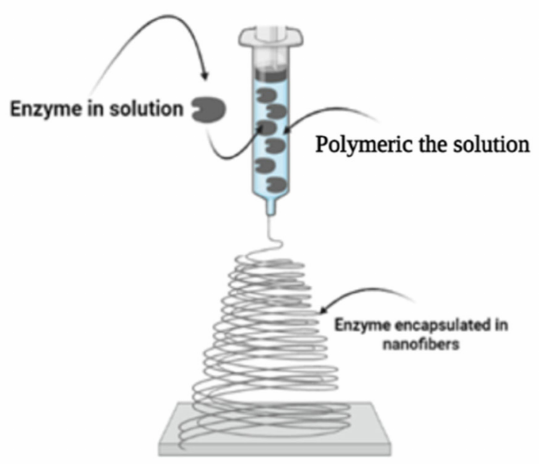
Figure 5. Electrospinning enzyme immobilization method. In this process, the enzyme is dispersed in the solution in which the process of physical/covalent adsorption and encapsulation of the